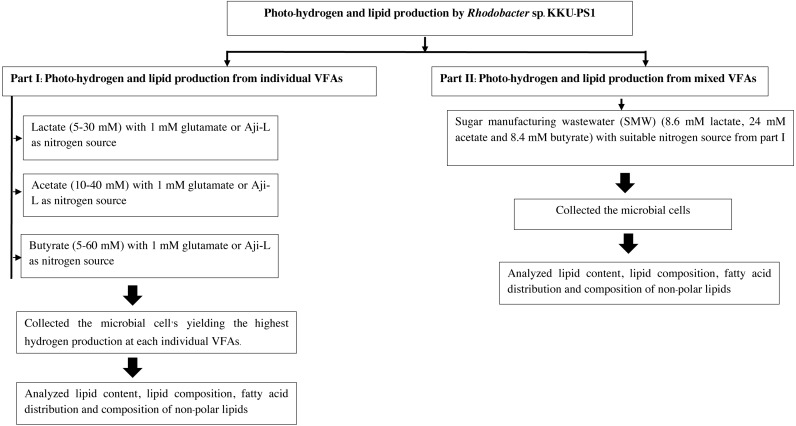
Experimental set up.